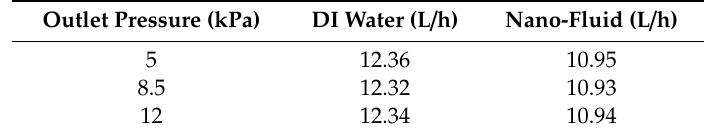
Table 3. Mass flow rate under different outlet pressures.